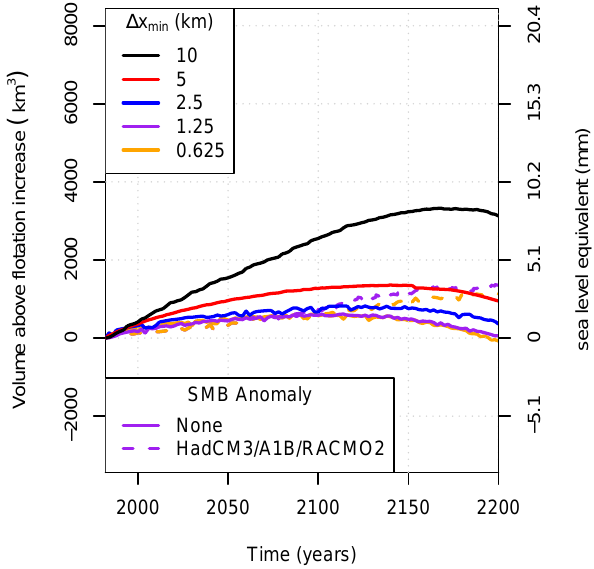
Figure 5. Mesh resolution and volume above flotation for the HadCM3/A1B/None/FESOM+ simulations. The importance of fine-mesh resolution is perhaps clearer in the evolution of volume above flotation than in grounding-line position. The coarsest reso- lution calculation results in 10mm of sea level fall over 220years, while the finest resolution calculations results in a 2mm fall over the first century and a 2mm rise in the second. The difference be- tween curves with finest mesh spacing 1x min and 2 1x min decays with 1x min . Only when 1x min ≤ 1 . 25km is the difference between successive curves much smaller than the difference caused by a change in forcing – in this case switching from no SMB anomalies to HadCM3/A1B/RACMO2